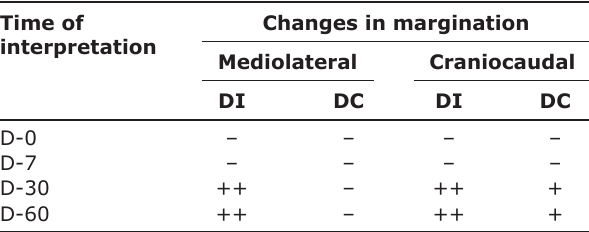
Table-3: Changes in bone margination based on time of interpretation (days) with mediolateral and craniocaudal radiographic images.